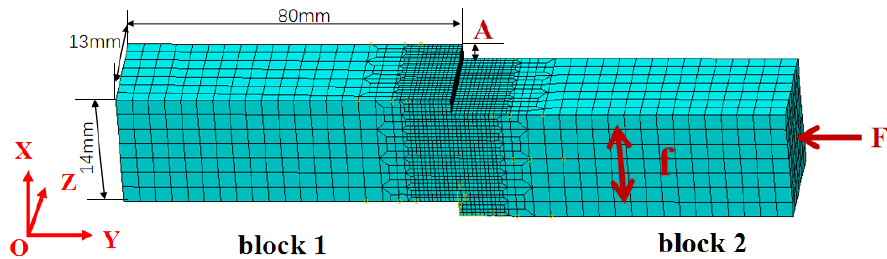
Figure 2. Schematic diagram of LFW.